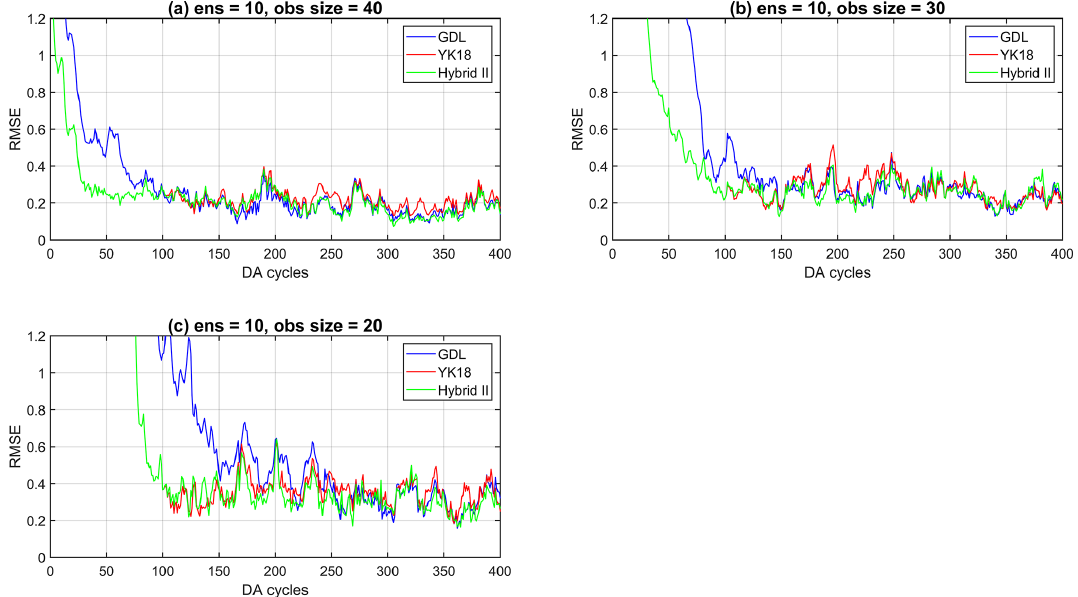
Figure 6. The analysis RMSE of the GDL (blue), YK18(red), and Hybrid II (green) with observations of (a) 40, (b) 30, and (c) 20 for the variant L96 model